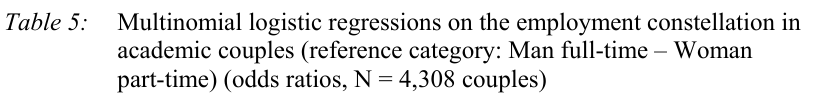
Both full-time Only man em- Unusual constel- employed ployed